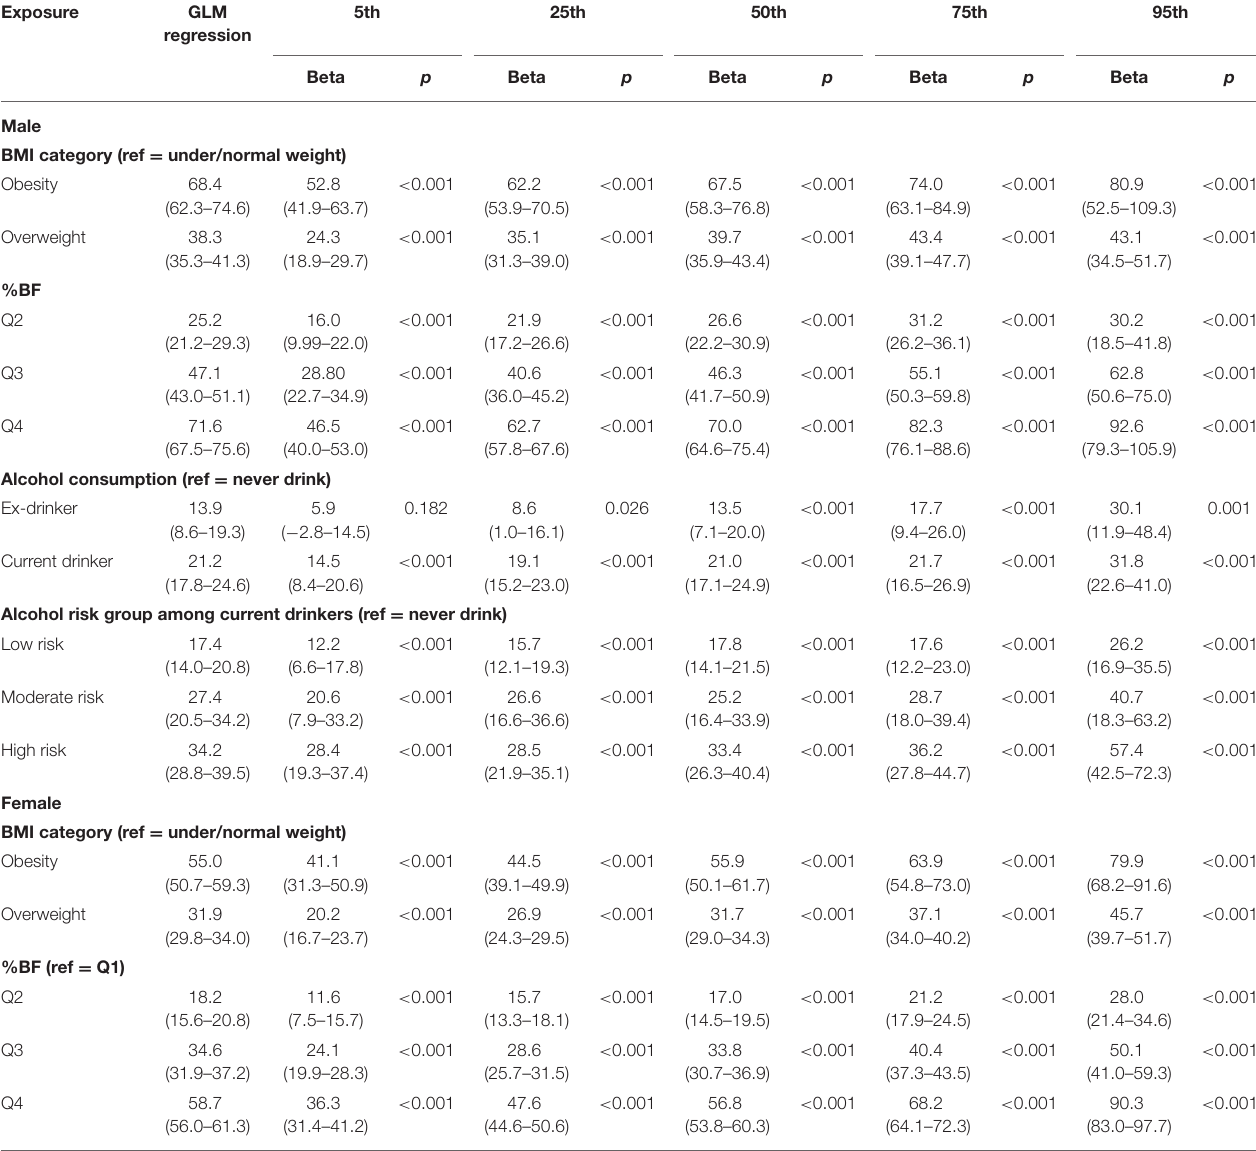
TABLE 3 | The association of excess bodyweight and alcohol consumption with SUA based on QR